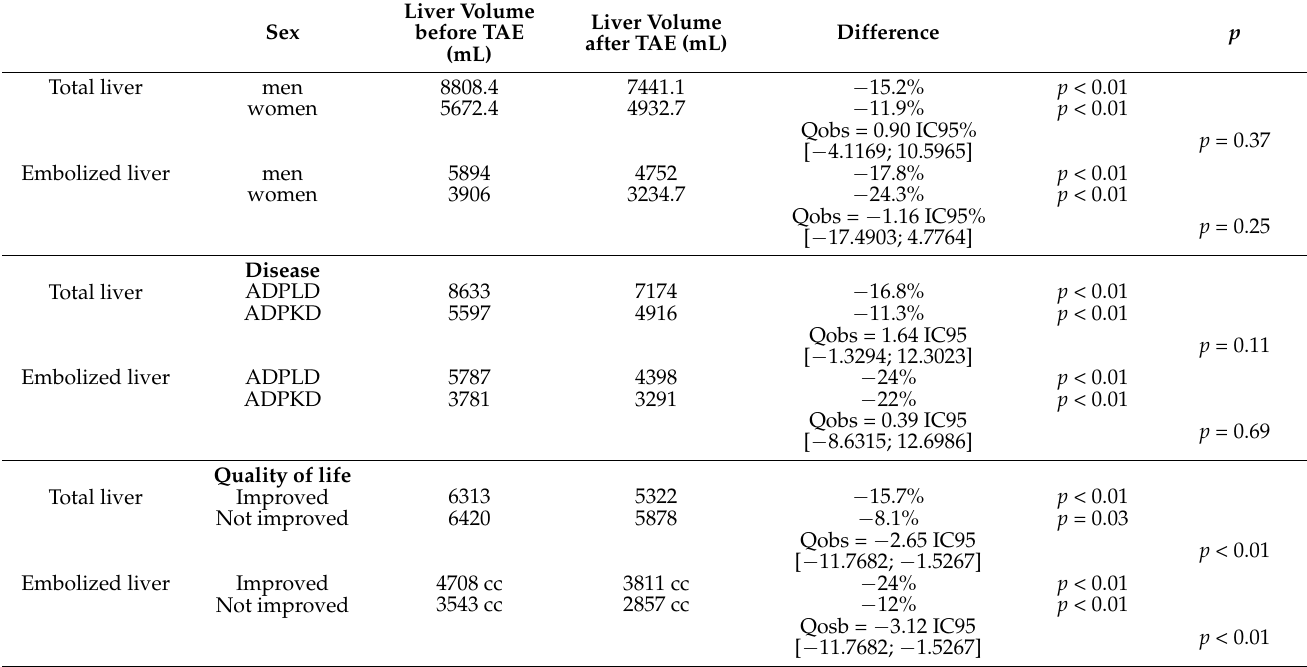
Figure 2. Computed Tomography (CT) from a patient with polycystic liver disease before and after transarterial embolization. ( a , b ) Pre-embolization CT showing a voluminous polycystic liver with a compression of the stomach by the cysts. ( c , d ) CT at 3 months showing coils and reduction of cysts volume. ( e , f ): CT at 4 years showing a significant liver volume reduction of 29% with a decompression of the stomach. Table 3. Liver volume reduction in sub group